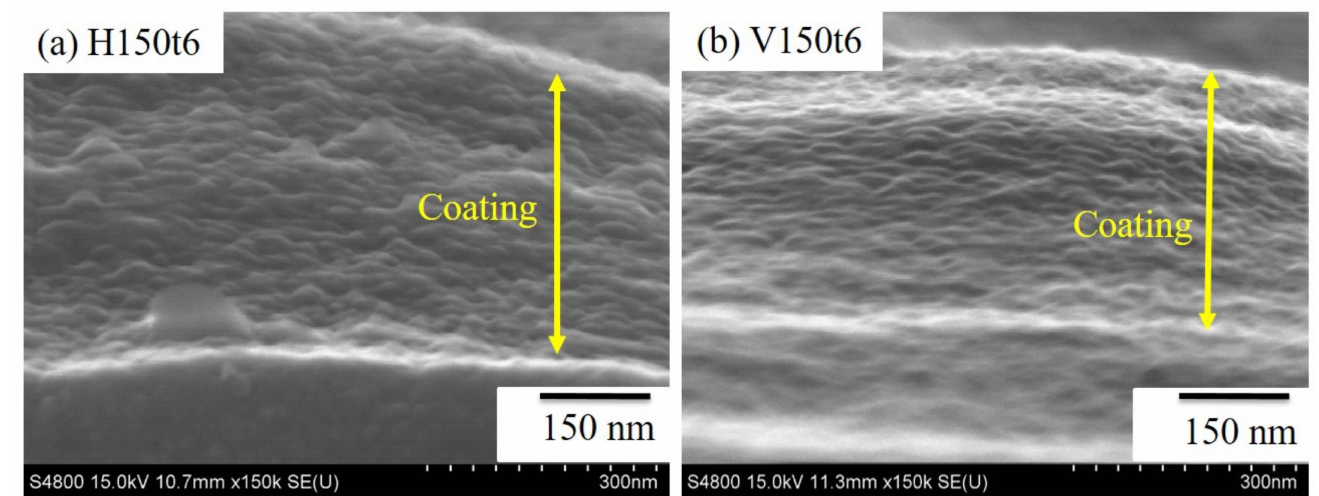
Figure 3. Cross-sectional SEM images of anodized Ti–5Nb–5Mo under various hydrothermal or vapor thermal treatments: ( a ) H150t6 and ( b ) V150t6.